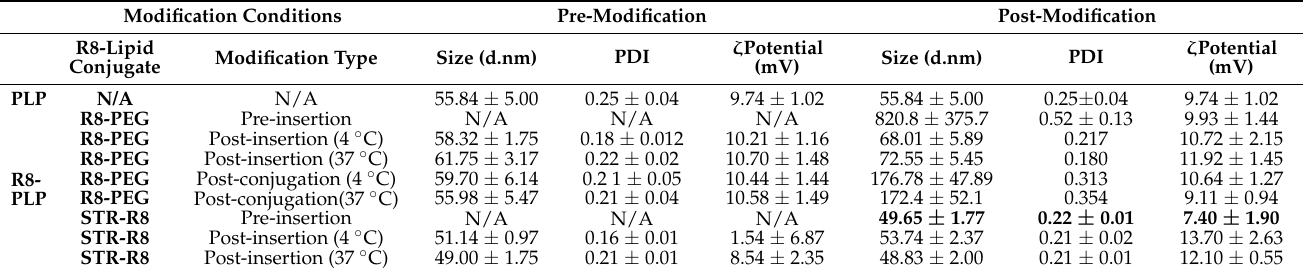
Table 3. Liposome characterization related to R8 modification and assembly